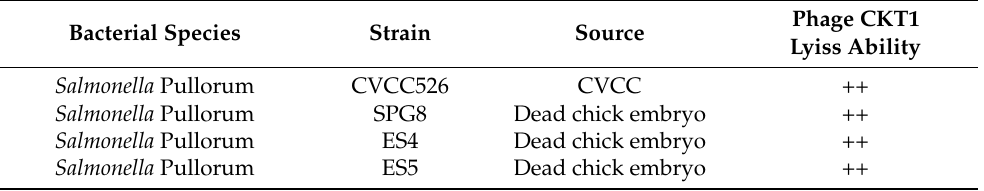
Table A1. Characteristics of bacterial strains for phage host range analysis used in this